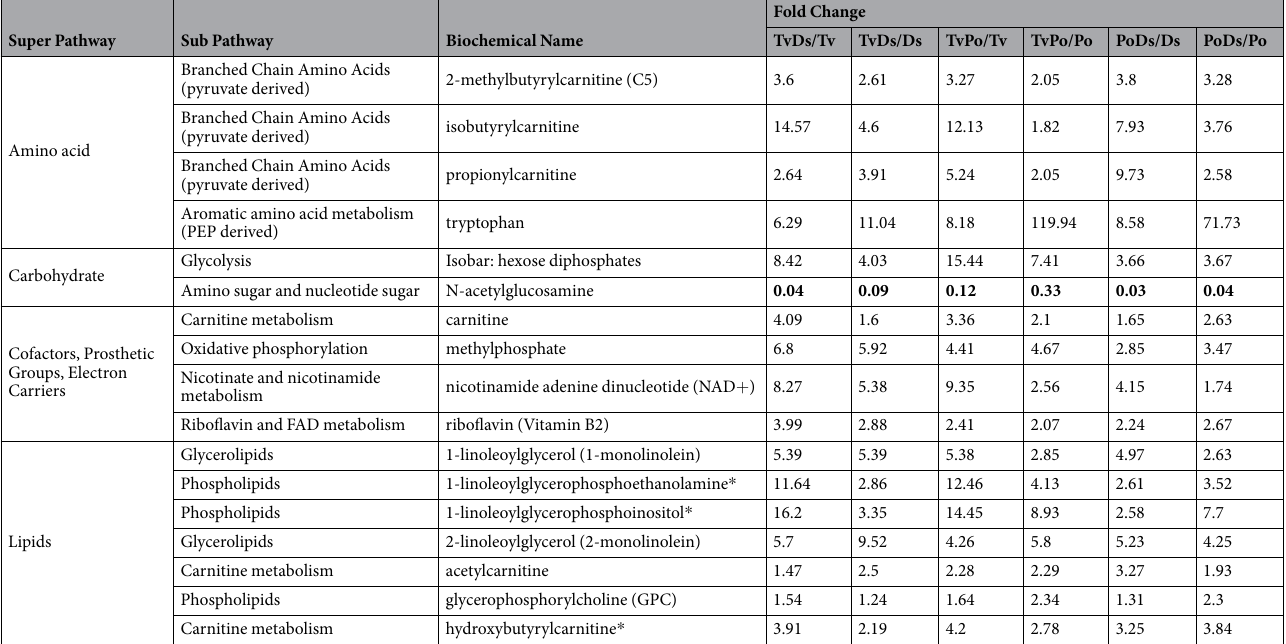
Table 1. Statistically significant metabolites in all